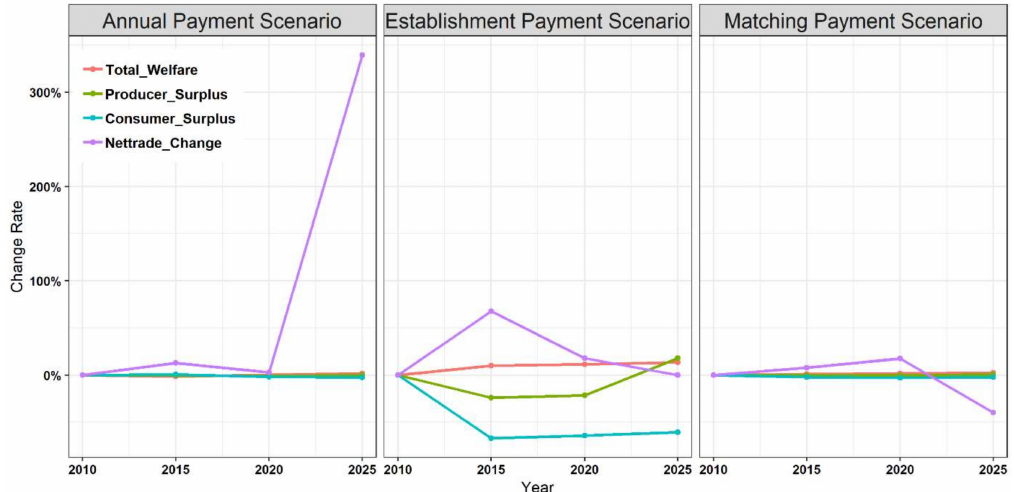
Figure 7. Welfare change under three